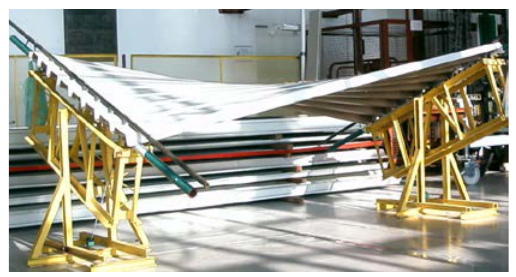
Figure 1. Experimental folded shell sheeting composed of eight folds belonging to two sheets supported by two straight skew